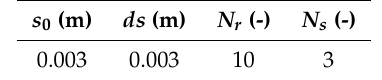
Table 7. New RBS parameters for the simulations.